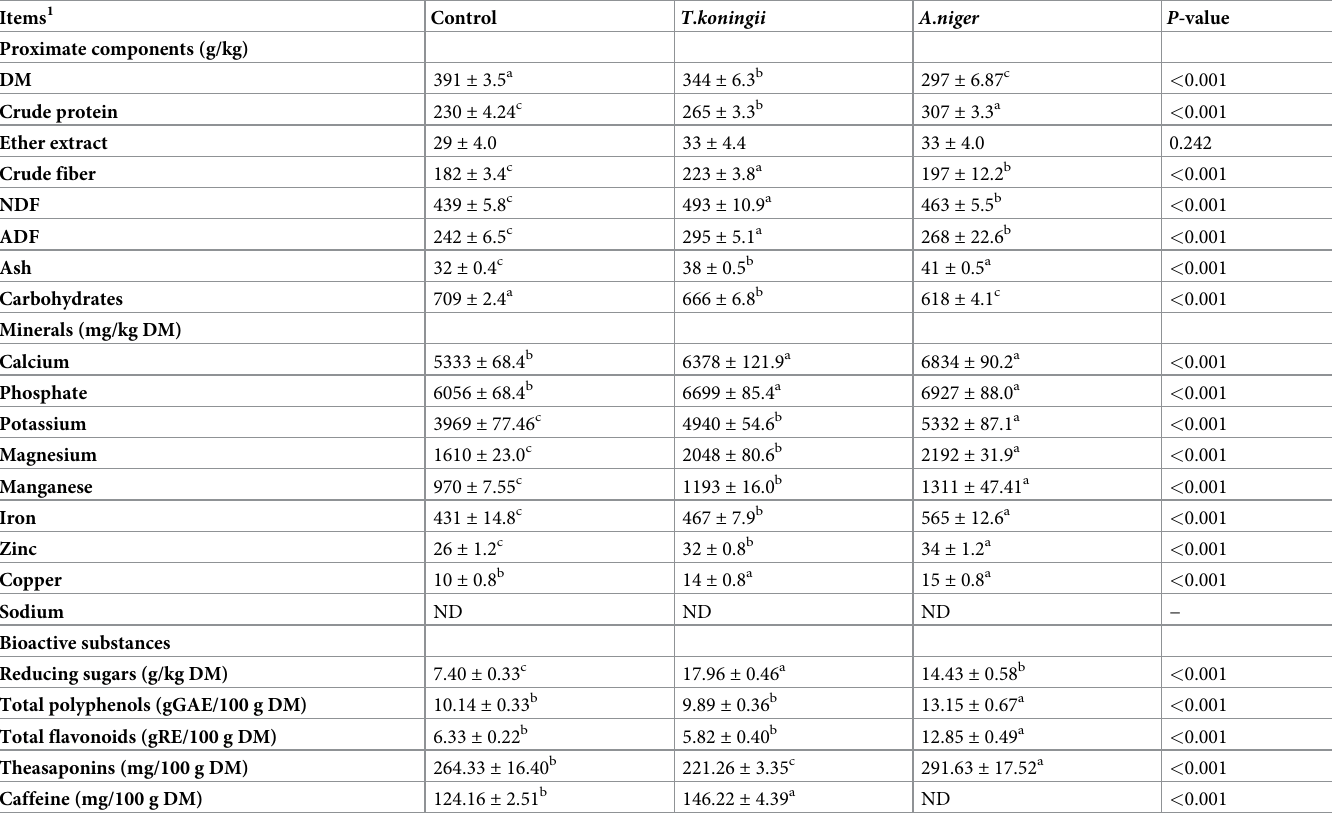
Table 1. Proximate components, minerals, and bioactive substances in the fermented tea dregs.